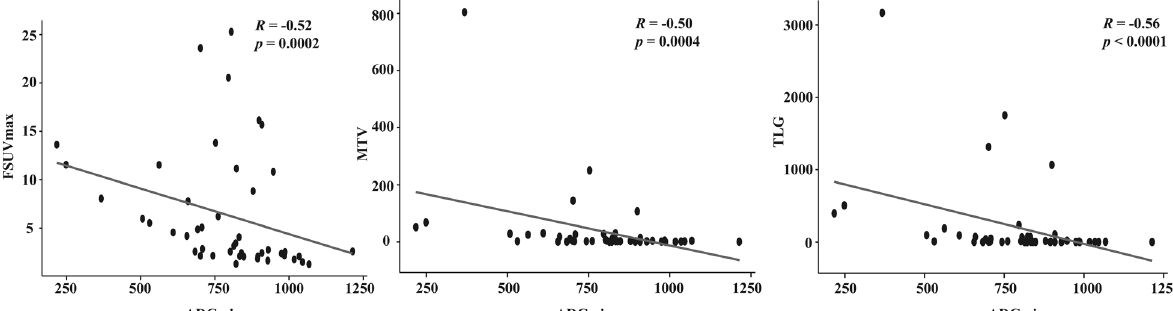
Fig. 1 The correlation between ADCmin and FSUVmax, MTV, and TLG. ADC Apparent diffusion coefficient, SUV Standard uptake value, MTV Metabolic tumor volume, TLG Total lesion